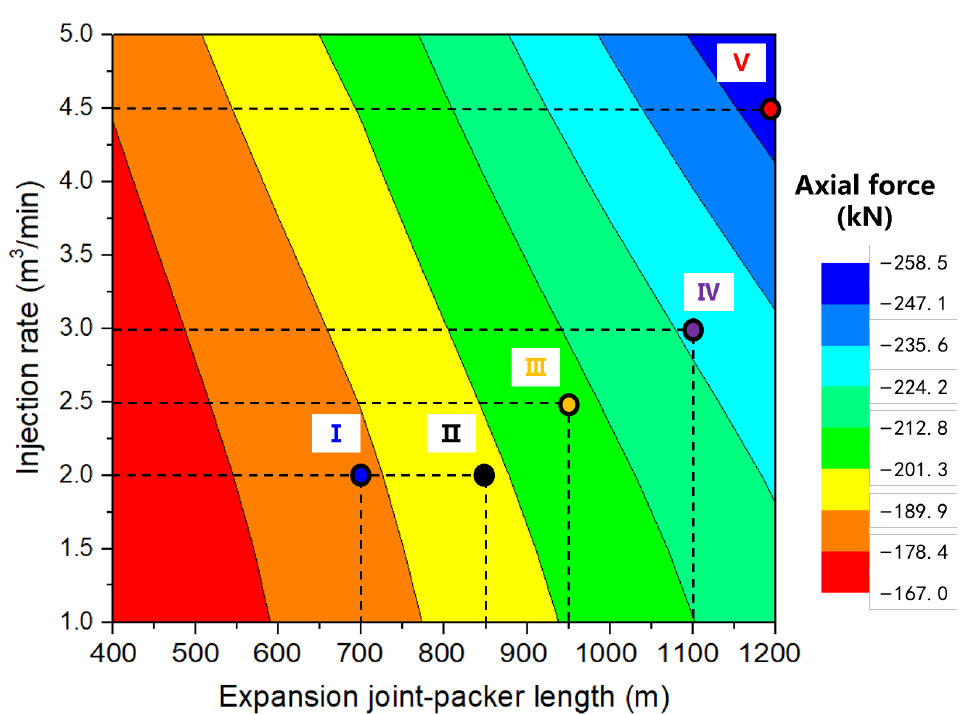
Figure 14. The axial force of the tubing string at above packer vs. injection rate and expansion joint–packer joint–packer length.